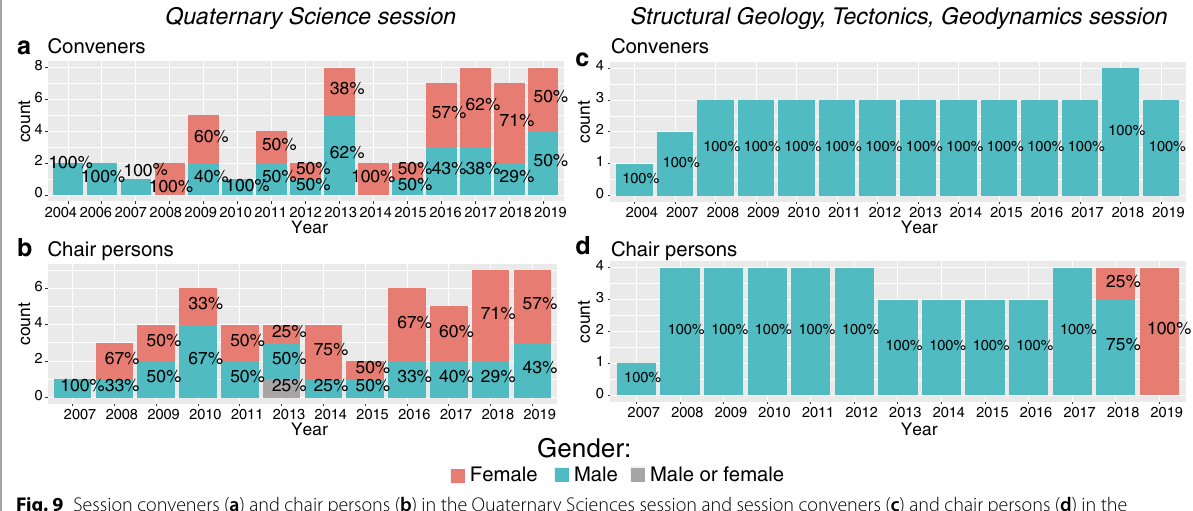
Fig. 9 Session conveners ( a ) and chair persons ( b ) in the Quaternary Sciences session and session conveners ( c ) and chair persons ( d ) in the Structural Geology, Tectonics and Geodynamics session classified by gender. Conveners and chair persons for which we were unable to retrieve the gender information are classified as Male or Female